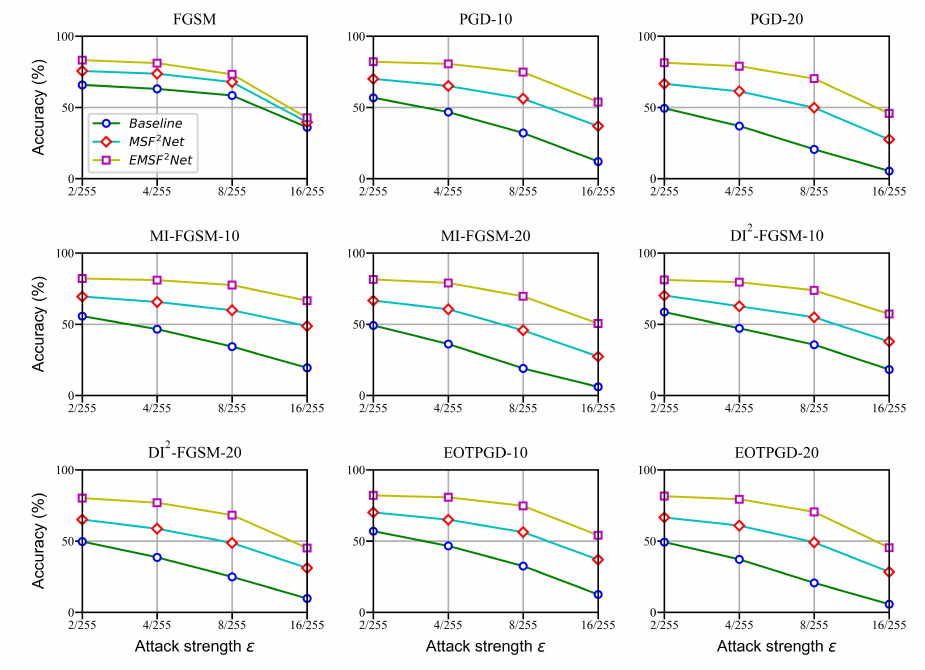
Figure 2. Robust classification accuracy of the baseline, MSF 2 Net, and EMSF 2 Net under adversarial attacks using the L ∞ -norm on the CIFAR-10 dataset.